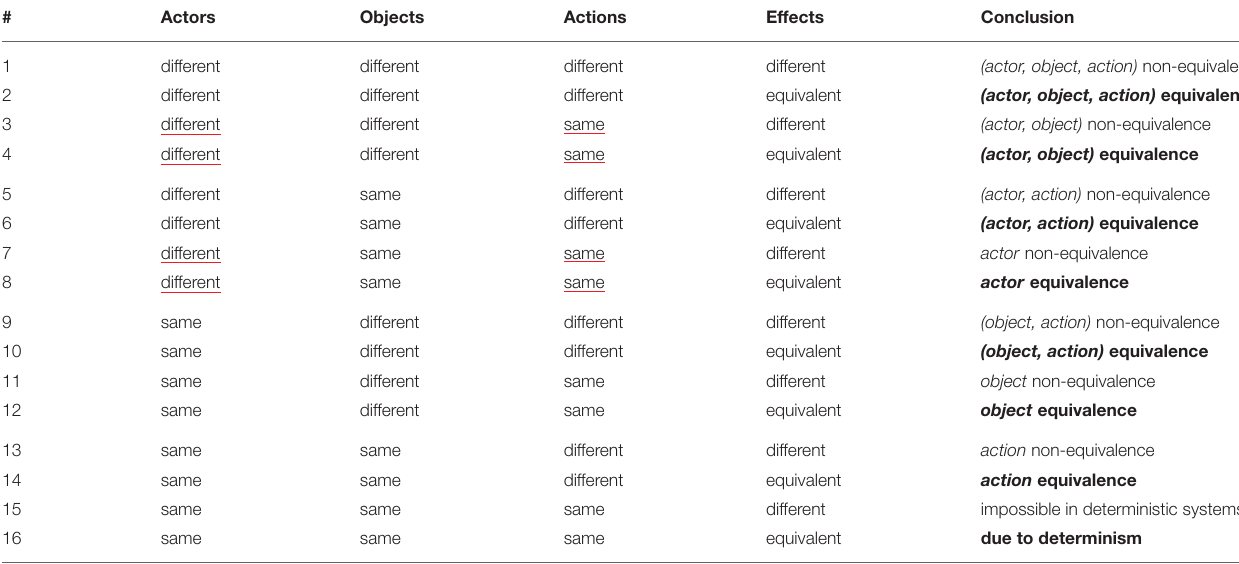
TABLE 1 | Comparison of two affordances, when actions are described with respect to actors.